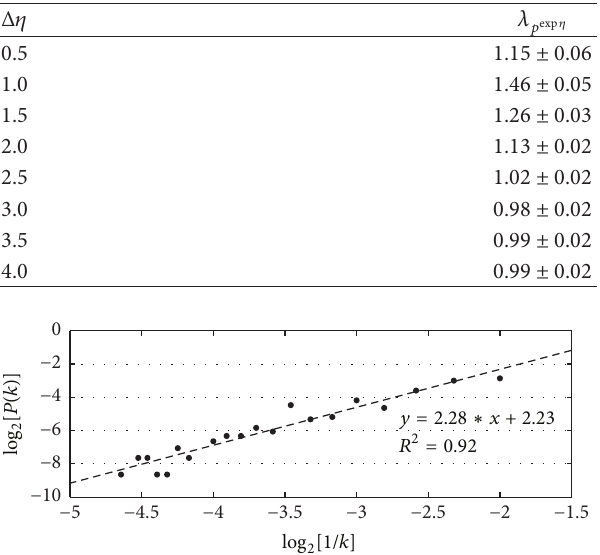
Table 1: Values of 𝜆 𝑝 exp for experiment data and 𝜆 𝑝 rand for random- ized data, calculated for void probability distribution for different 𝜂 -range around the central rapidity regions.